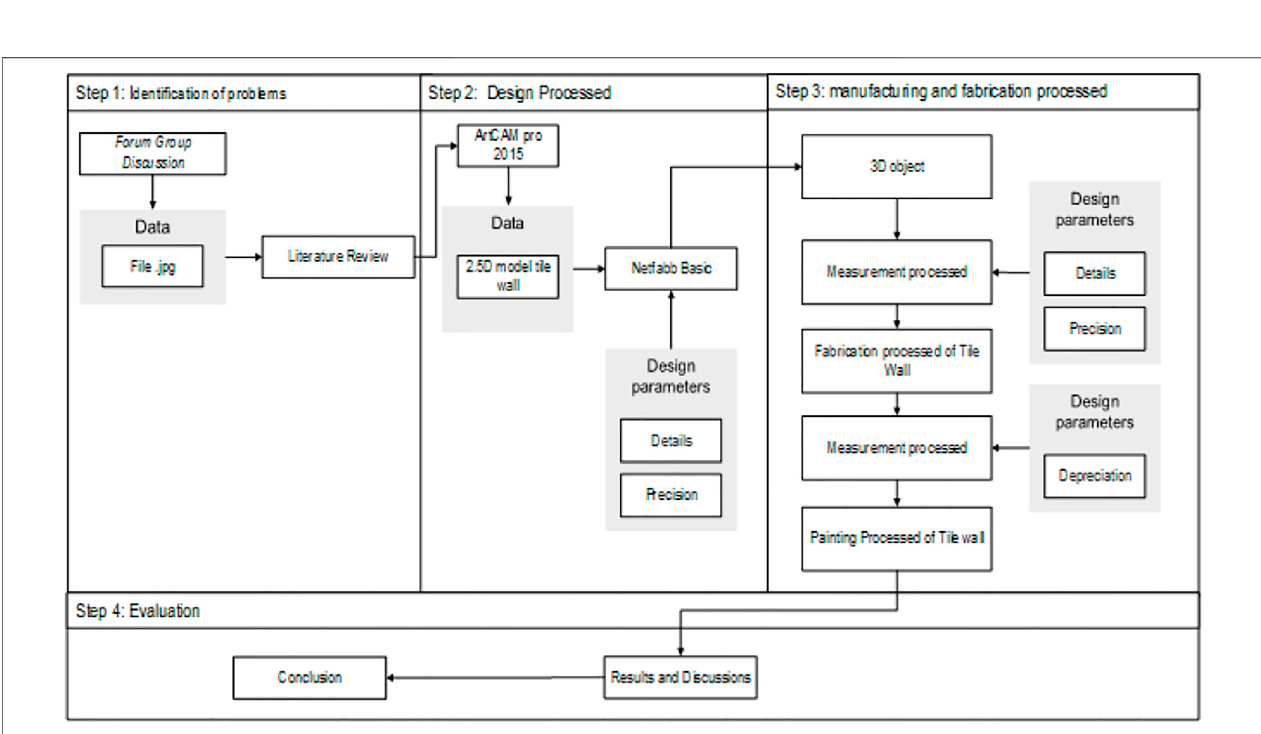
Frontiers in Mechanical Engineering |